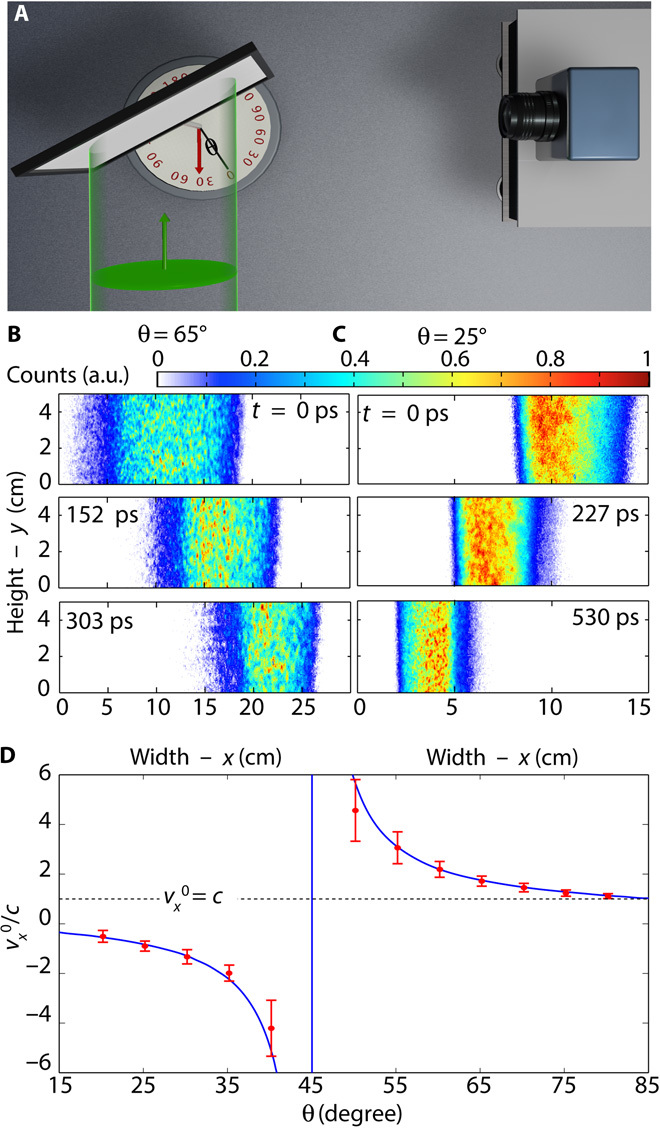
Time order inversion.(A) A sketch of the experiment. A plane wavefront (green) impinges on a tilted screen, and the scattered radiation is recorded at 90° with a time-resolving intensified charge-coupled device (iCCD) camera. Changing the angle θ between the input wave and the screen allows a change in the scattering source velocity component along the camera/observer direction. (B) Three snapshots acquired by the camera at three different times for an incident angle (θ = 65°) such that the scattering speed toward the camera is subluminal. In this case, the time order is maintained and the perceived source moves from left to right (full video available as Supplementary_Video_1.mp4). (C) For θ = 25°, the source velocity toward the detector is superluminal and event time ordering is reversed; that is, the same wavefront measured in (B) is now seen as propagating in the opposite direction, from right to left (full video available as Supplementary_Video_2.mp4). (D) The measured speed along the x direction (red dots) compared with the theoretical prediction (blue curve).